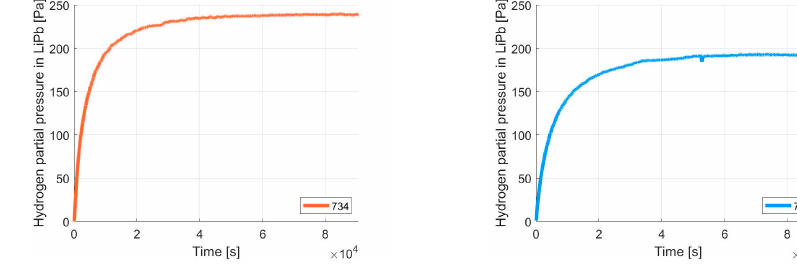
Figure 3. Example of commissioning test for sensors HLM733, HLM734, and HLM735.